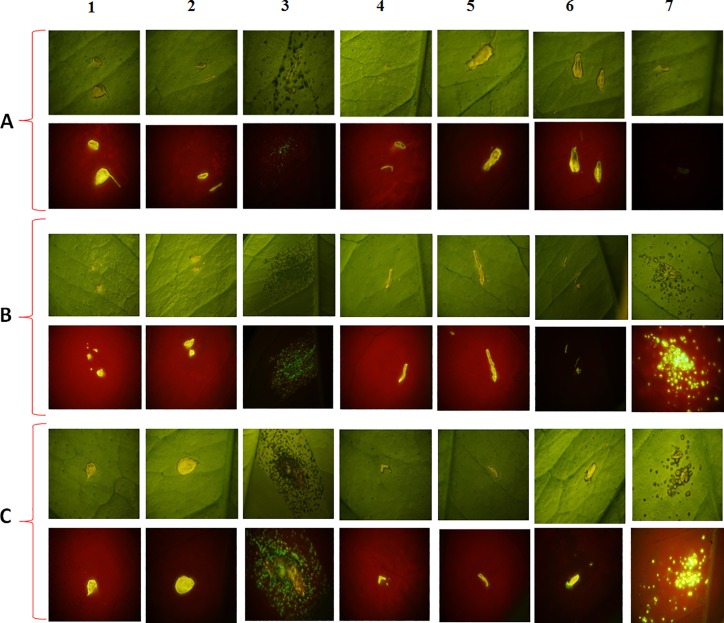
Qualitative evaluation of AMP activity against X.citri in C. sinensis.(A) 7dpi, (B) 14 dpi, (C) 21dpi, (1) Tritrpticin, (2) PBS buffer, (3) X.citri::GFP, (4) Hylin-a1, (5) Ocellatin4-Analogue (6) Citrus–amp 1 and (7) K0-W6-Hy-a1.